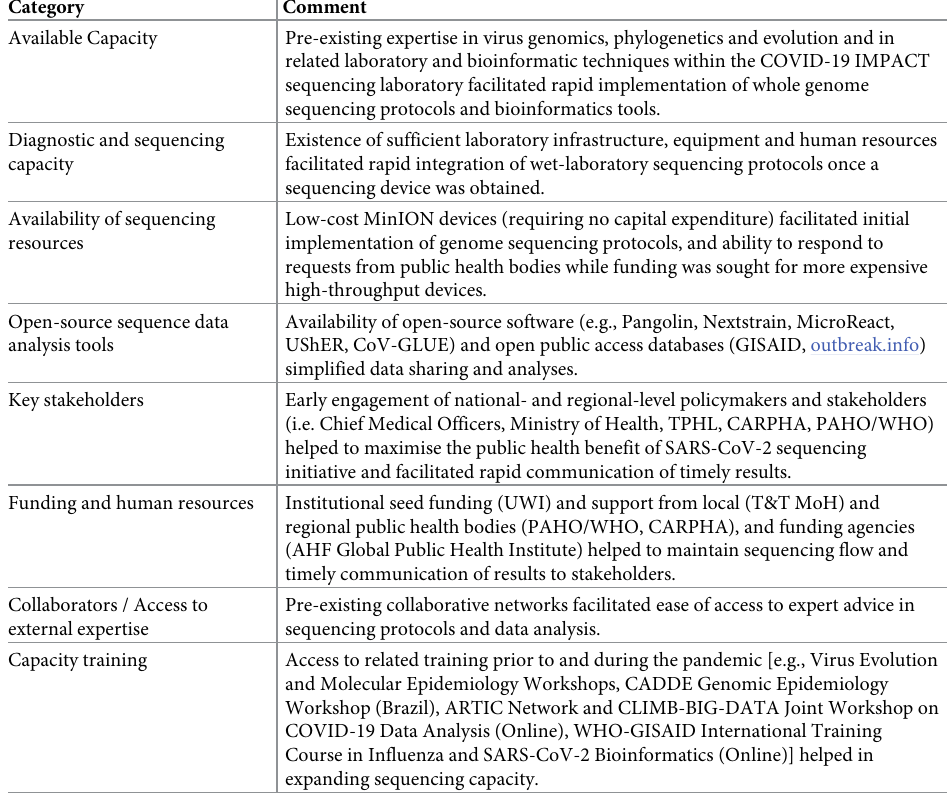
Table 2. Considerations in the implementation of the COVID-19 IMPACT genomic surveillance programme, its public health objectives and policy